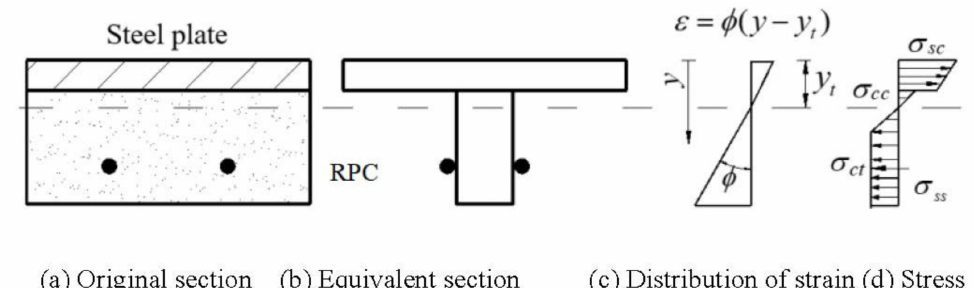
Figure 17. Calculation diagram of reinforcement